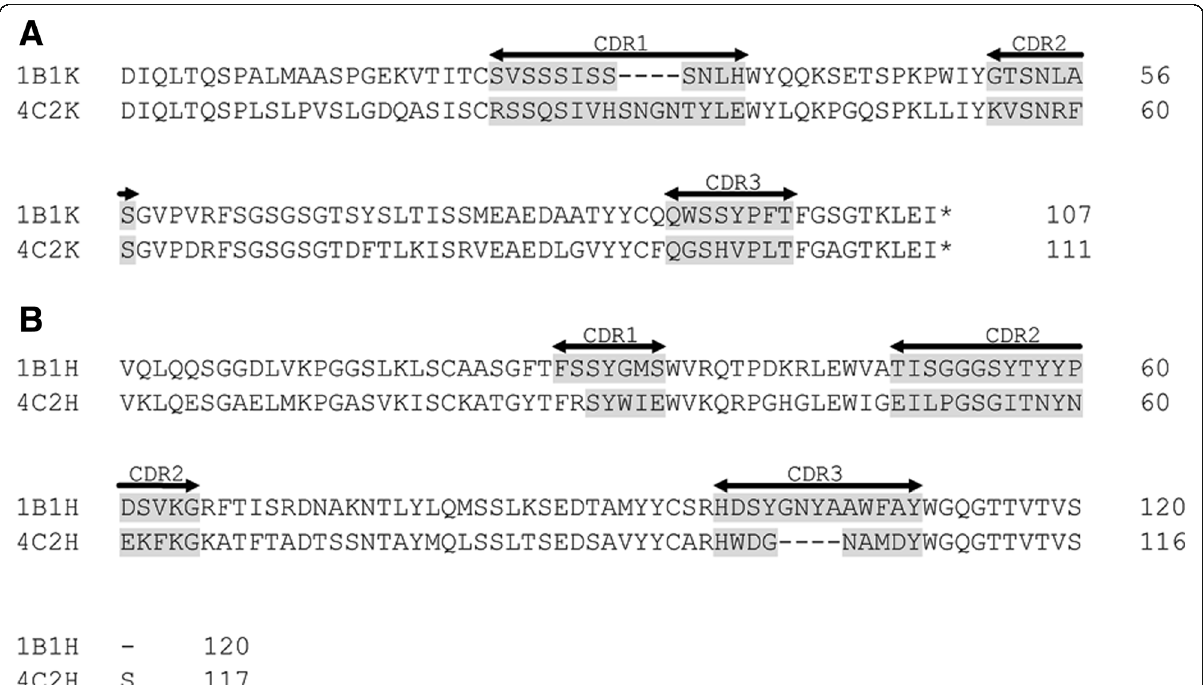
Fig. 3 Alignments of amino acid sequences of the ( a ) light- and ( b ) heavy-chain regions of mAbs 1B1 and 4C2. Complementarity-determining regions (CDRs) are shaded